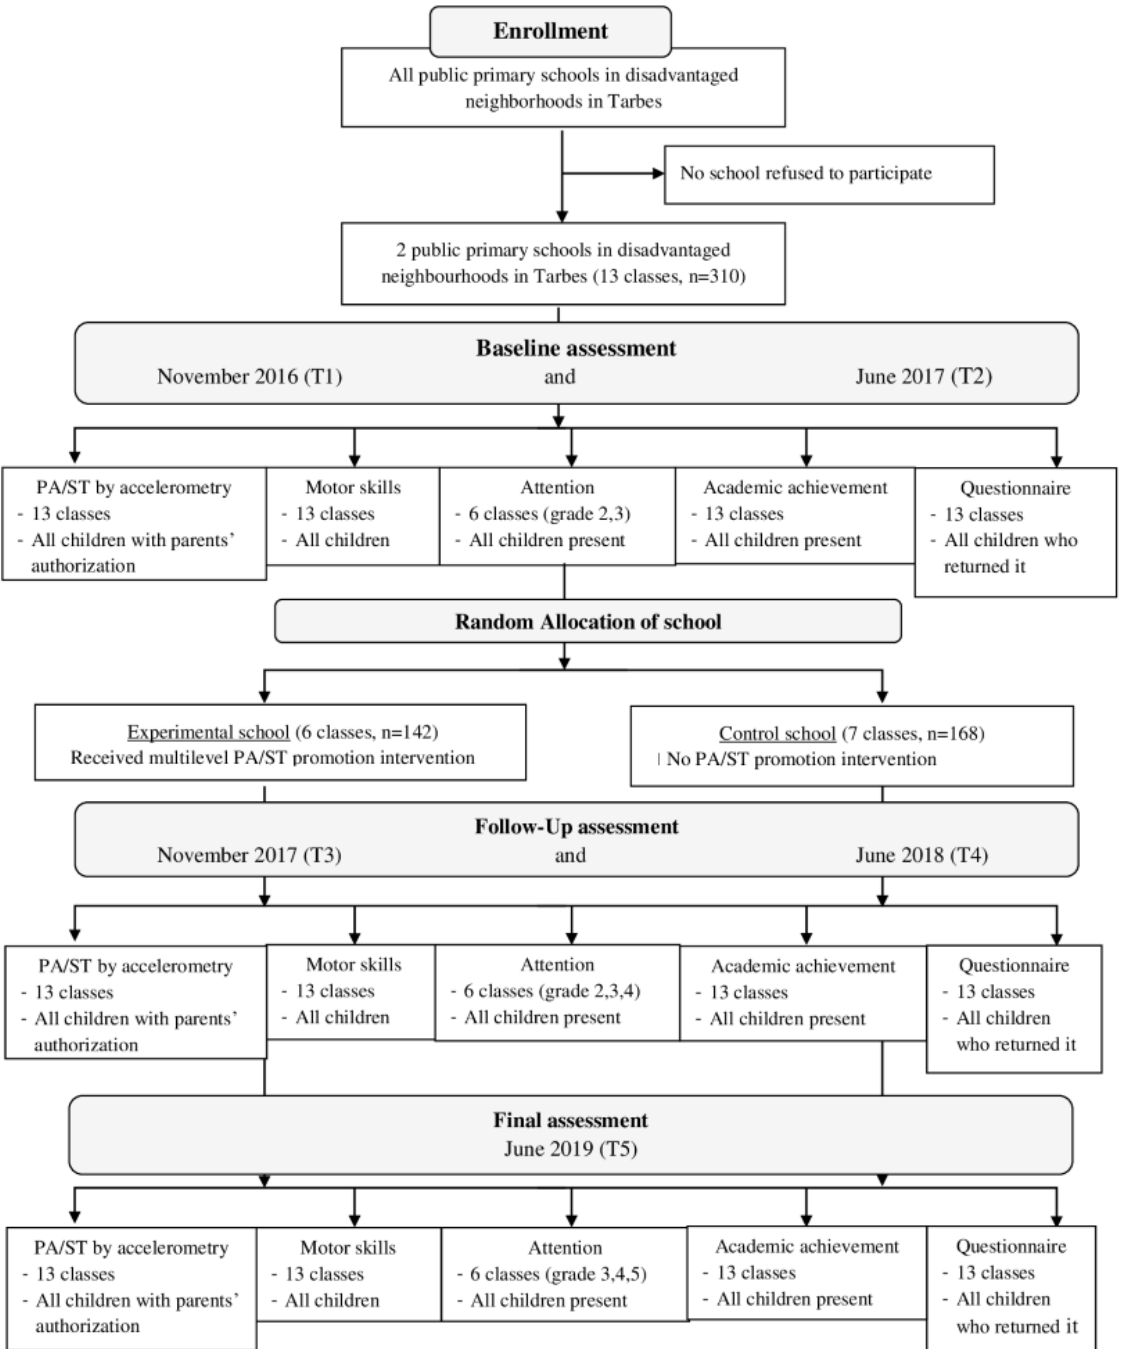
Figure 1. Flowchart of participants. PA: physical activity; ST: sedentary